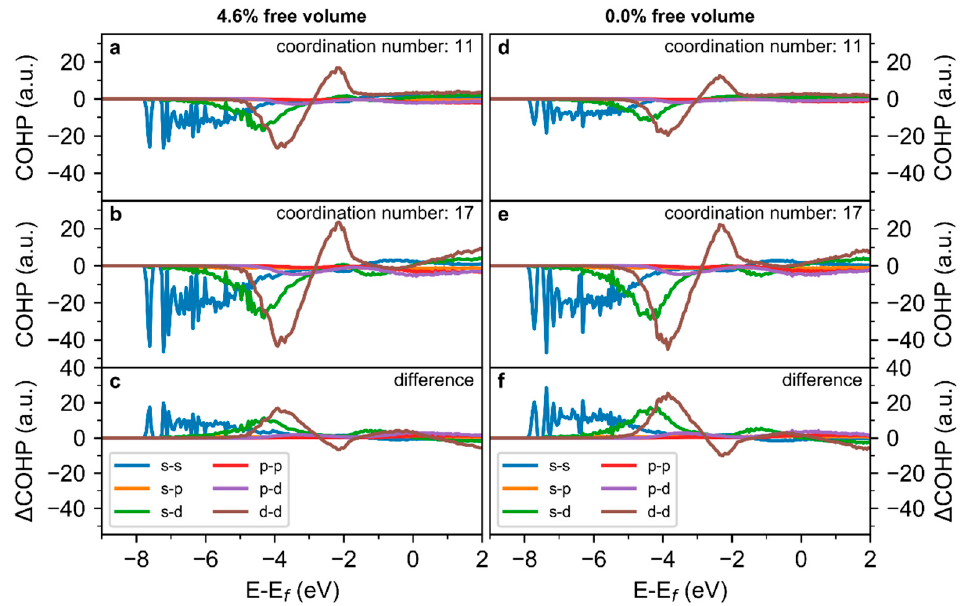
Figure 3. Band-resolved COHP of Cu 70 Zr 30 metallic glass with a ( a – c ) 4.6% and ( d – f ) 0.0% free volume content. ( a , d ) show the COHP for atoms with a coordination number of 11, ( b , e ) for a coordination number of 17, and ( c , f ) the difference between a low and high coordination number.